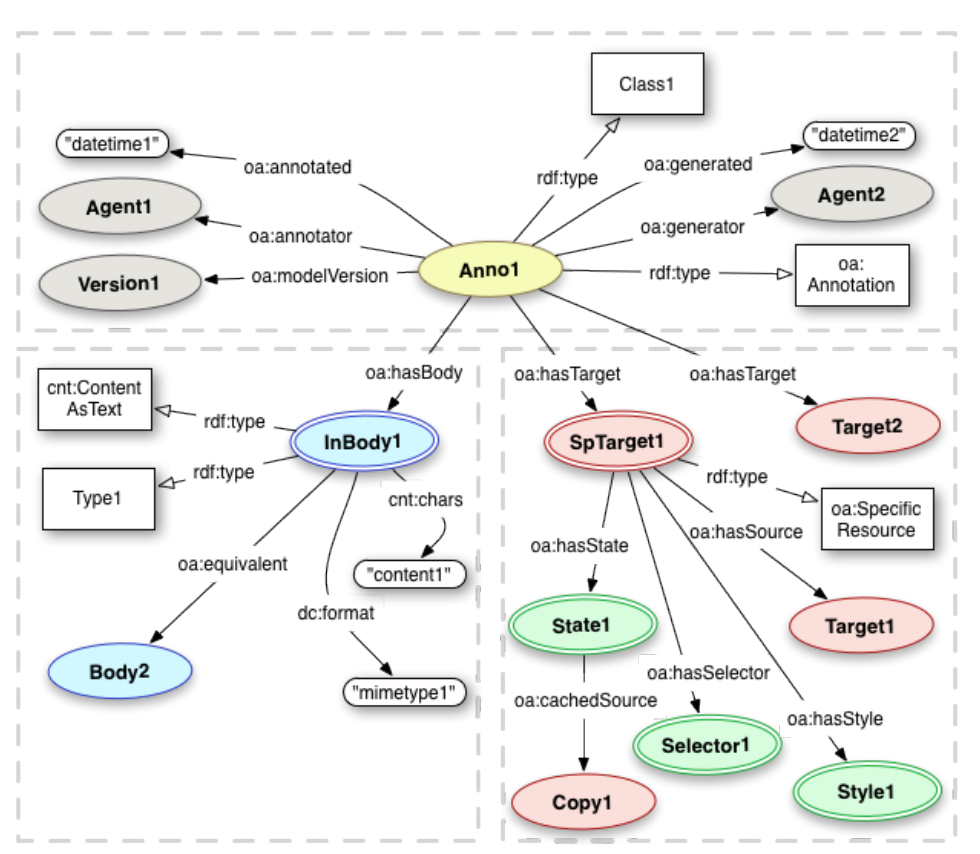
Figure 1. The Open Annotation (OA)